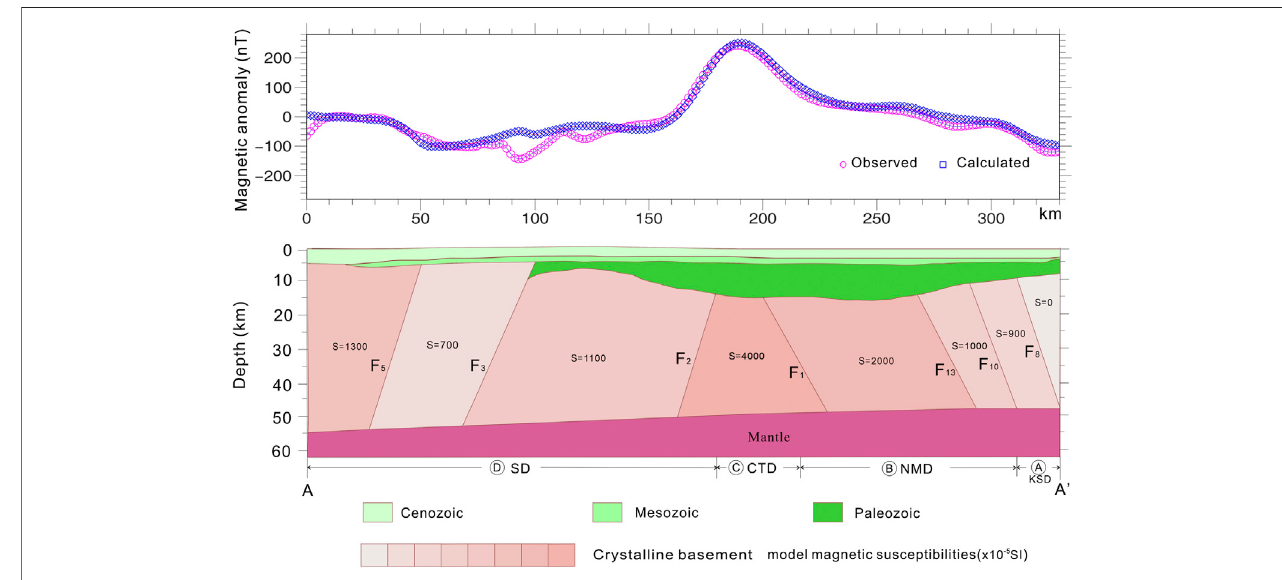
FIGURE7| Pro fi leAA ′ formagneticforwardmodeling,pro fi lelocationshowedin Figure3A .Top:observedandcalculatedmagneticdata;bottom:lithologicpro fi le ofcrustanduppermostmantle withmodeledmagneticsusceptibilities.F1andsoonarethefaultsofthebasement; “ S ” meanssusceptibility; Ⓐ andsoonarethemarks of crystalline basement domains, and “ KSD ” and so on are the abbreviations of names of crystalline basement domains, for better understanding of the marks and abbreviations please see Figure 12 and the text.